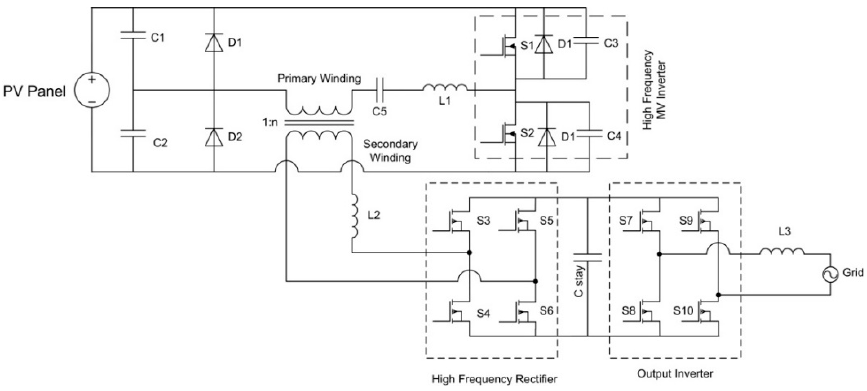
Figure 4. Circuit layout for photovoltaic (PV) high-frequency-based medium voltage (MV) inverter system.